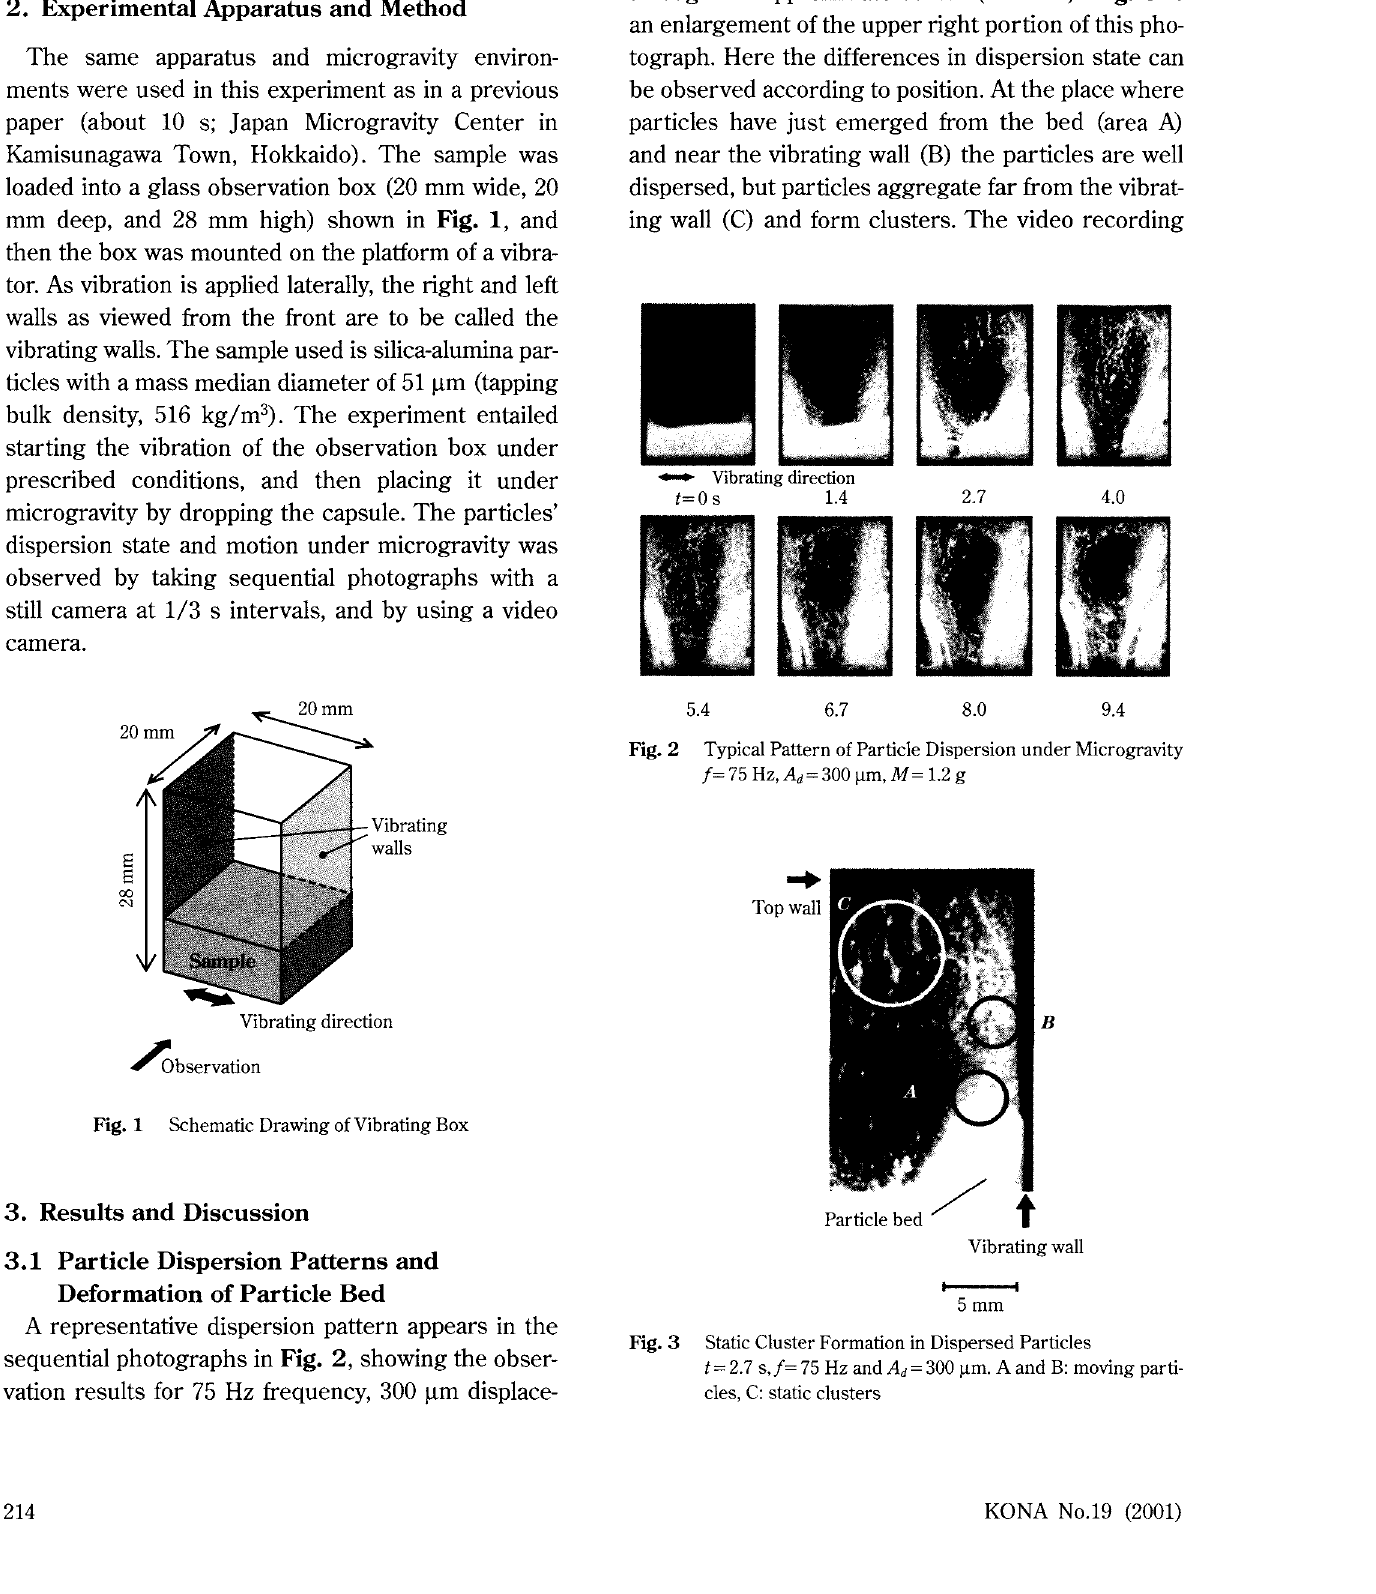
Static Cluster Formation in Dispersed Particles t= 2.7 s.f= 75Hz and Ad= 300 ~m. A and B: moving parti cles, C: static